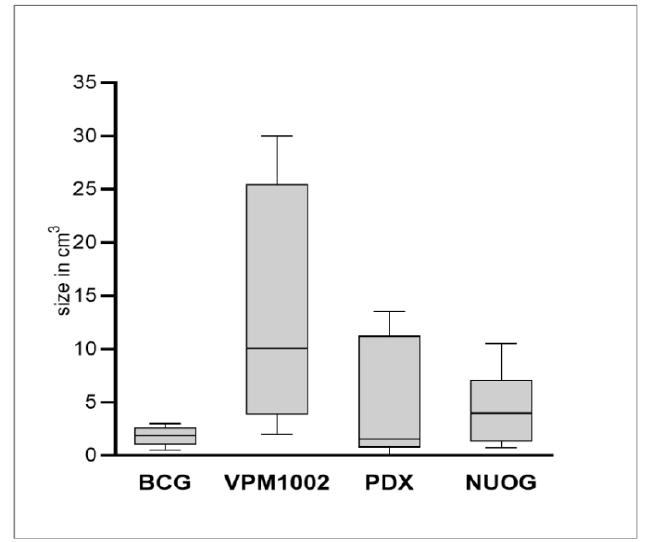
Figure 2. Size (volume) of granulomas induced in goats by subcutaneous injection of BCG, VPM1002, PDX and NUOG. Each column represents measurements from six goats. Interquartile range (grey box), median (line) as well as maximum and minimum size (whiskers) are indicated.